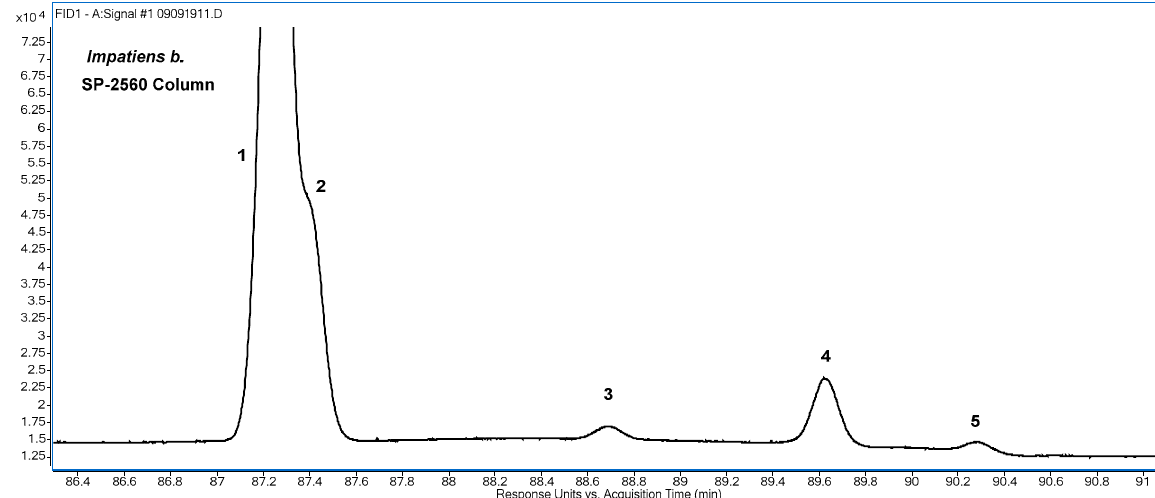
Figure 6. CSDA region of FID chromatogram of Impatiens b. obtained using the SP-2560 column. Peak 1 is assigned as the FAME of α -parinaric acid ( cttc ); peak 2 is assigned as the FAME of the cttt isomer; peak 3 is a possible CSDA isomer of unknown geometric configuration; peak 4 is assigned as the FAME of the tttc isomer; and peak 5 is assigned as the FAME of β -parinaric acid ( tttt ).